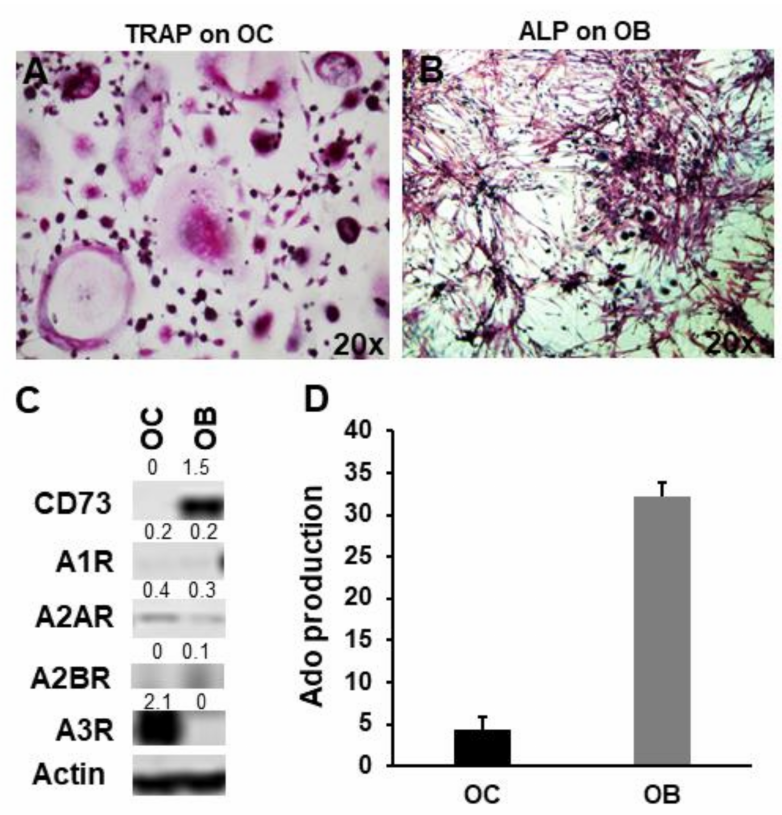
Figure 2. CD73 and Ado production by OBs and OCs. ( A ) OCs positive for TRAP staining and ( B ) OBs for alkaline phosphatase (magnification 20 × ). ( C ) Western blot analysis of CD73 and Ado P1 purinergic receptors is shown. Quantification of each bar is reported. ( D ) Bars indicate the quantification of Ado production, as mean area % of the peaks ± SD, by OCs and